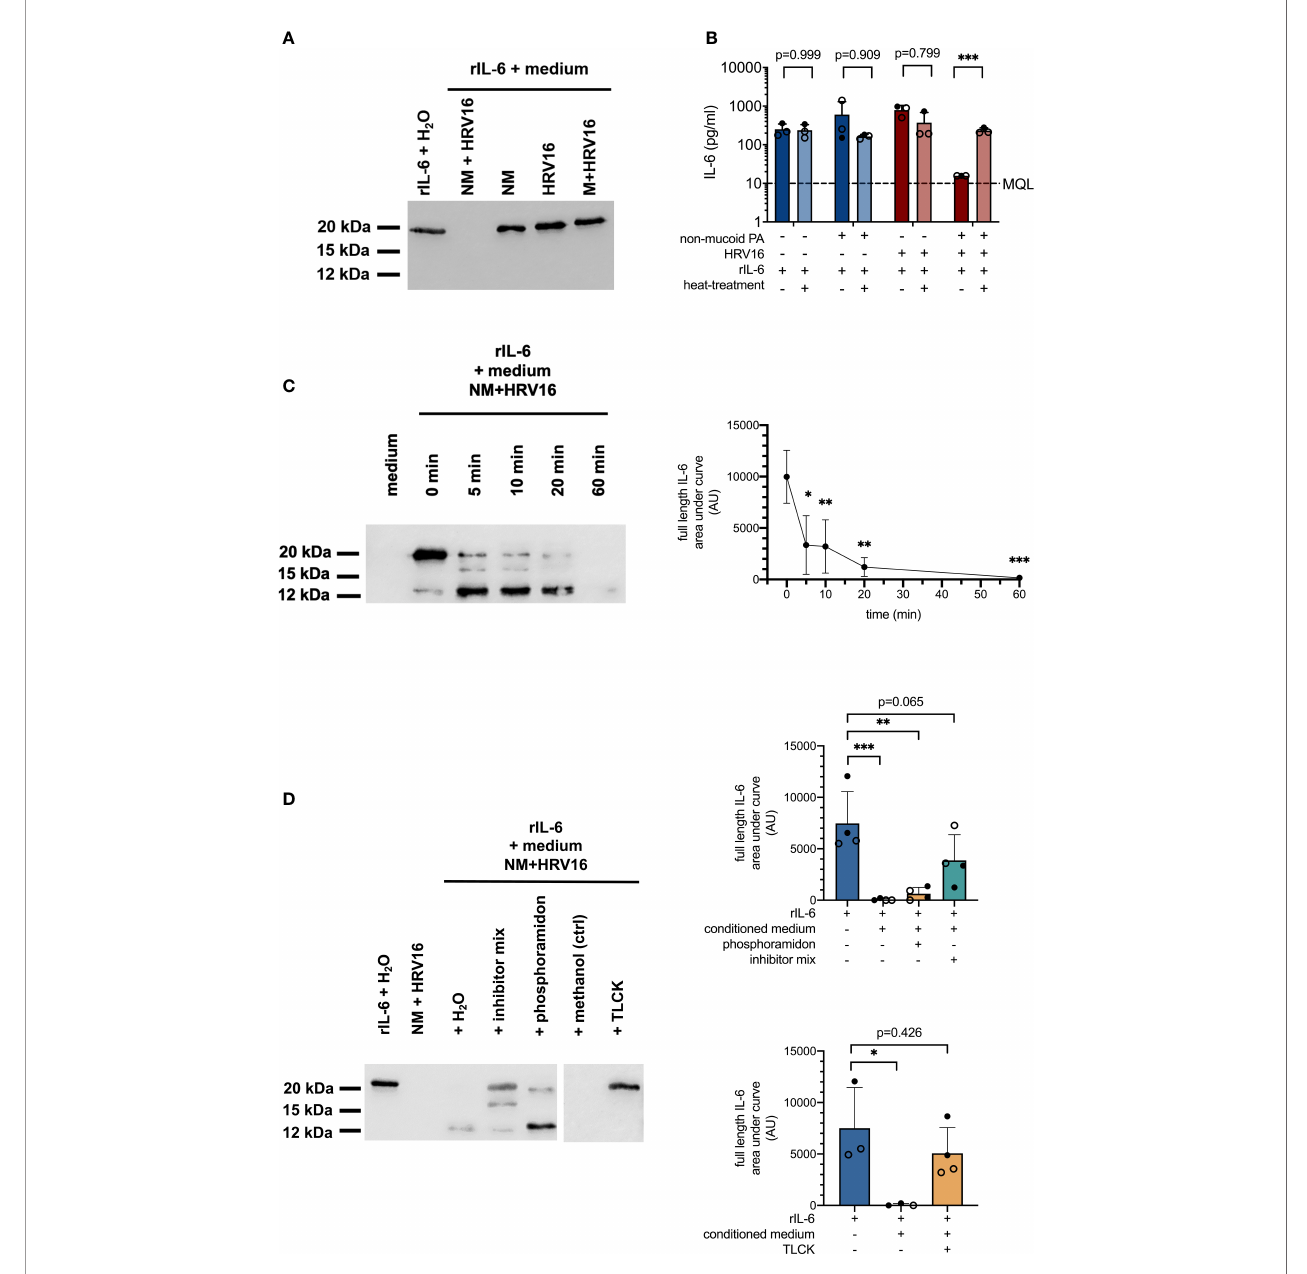
FIGURE 3 | Proteolytic degradation of recombinant IL-6 by conditioned media from PA/HRV16 co-infections. (A) Western Blot (IL-6) for rIL-6 incubated with conditioned media or H 2 O for 4 h (IL-6). (B) ELISA (IL-6) of rIL-6 incubated with either untreated or heat-inactivated (95°C/5 min) conditioned media obtained from infection experiments. (C) Time course series: rIL-6 was incubated with conditioned media obtained from non-mucoid PA+HRV16 co-infections for the indicated times and samples were subsequently analyzed by Western Blot and densitometry for full length IL-6. (D) rIL-6 was incubated with conditioned media in the presence of the indicated protease inhibitors and samples were analyzed by Western Blot and densitometry for full length IL-6. NM, non-mucoid PA isolate; M, mucoid PA isolate. Cell type: ○ Emphysema ● Cystic fi brosis. Western blots (A, C, D) are representative images of three to four independent experiments. ELISA data (B) and densitometry show mean +/- SD of three independent experiments. *p ≤ 0.05, **p ≤ 0.01, ***p ≤